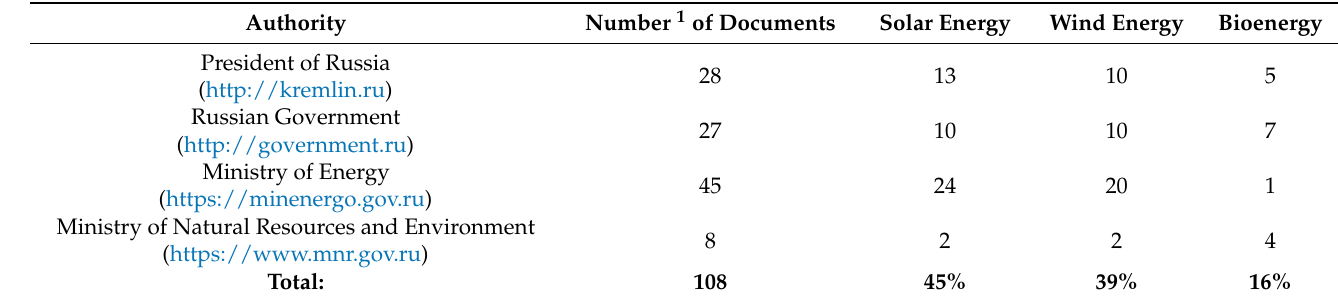
Table 4. Energy sources mentioned in the speeches/newsletters of various authorities.